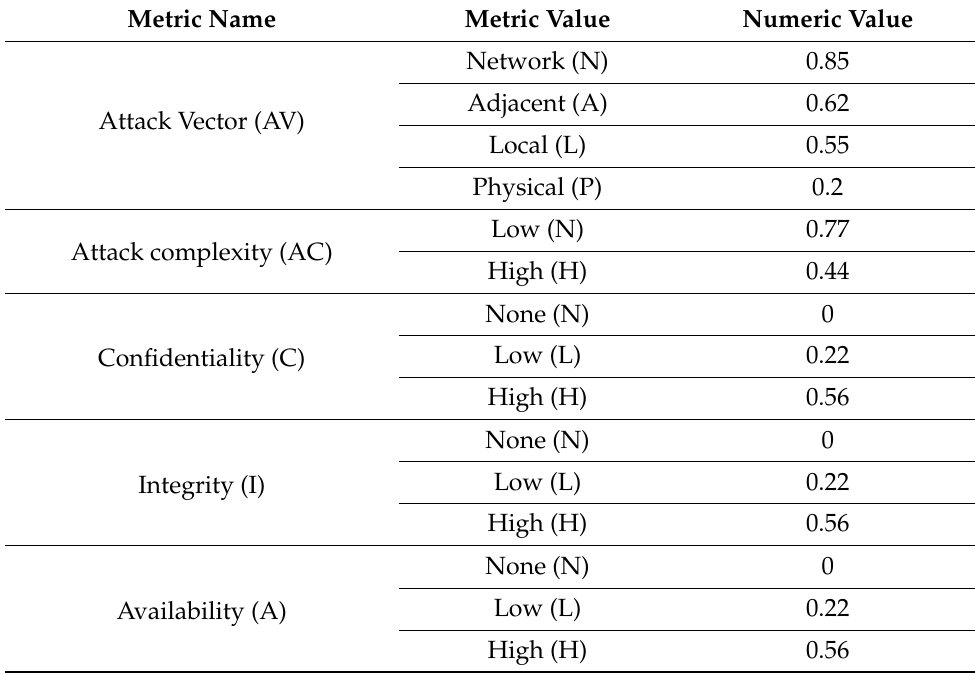
Table 4. CVSS v3.1 metric and the value used in ACVRM patch score